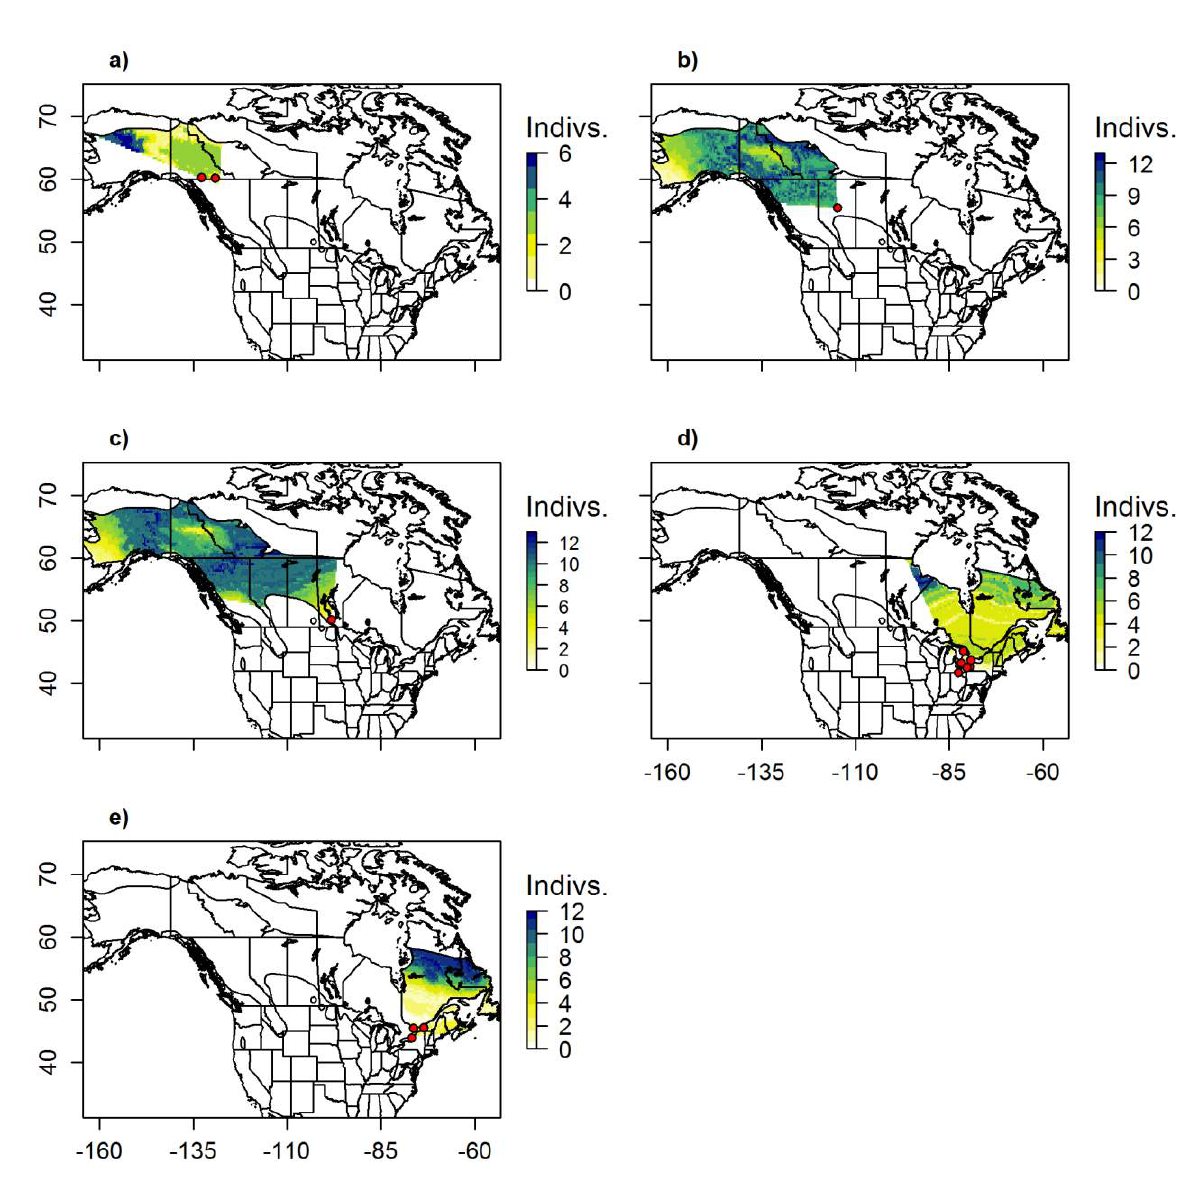
Figure A2.9: Probable origins of Northern Waterthrushes ( Parkesia noveboracensis ) captured during spring migration at CMMN stations in a) Yukon (ACBO (n=9) and TLBBS (n=6)), b) Northern Alberta (LSLBO (n= 23)) c) Manitoba (DMBO (n=25)); d) Southwest Ontario (AuBO (n=5), BPBO (n=2), HBO (n=5), LPBO (n=5), PIBO (n=3), TTPBRS (n=5)); and e) Southeast Ontario & Southwest Québec (IPBO (n=6), MBO (n=8), PEPTBO